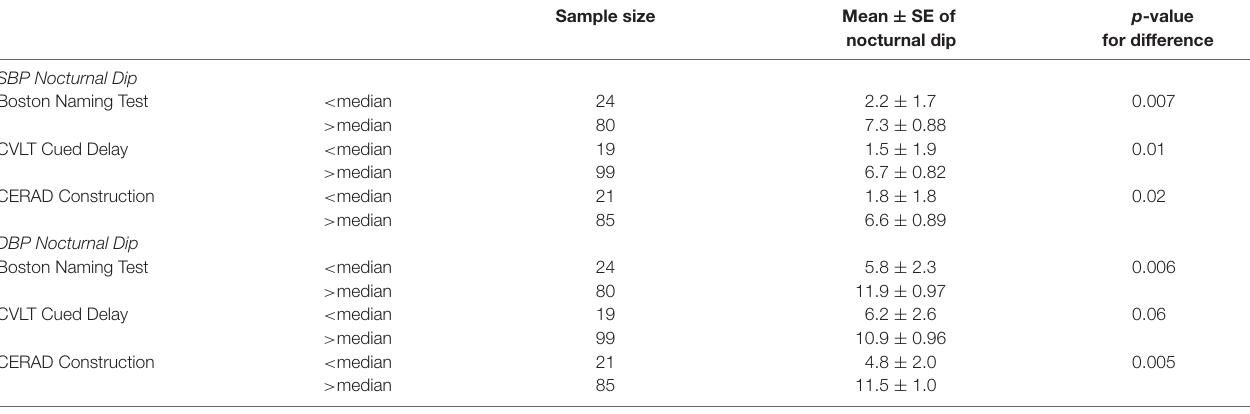
TABLE 5 | Nocturnal dips (Mean ± SE) by cognitive tests scores (below and above median).